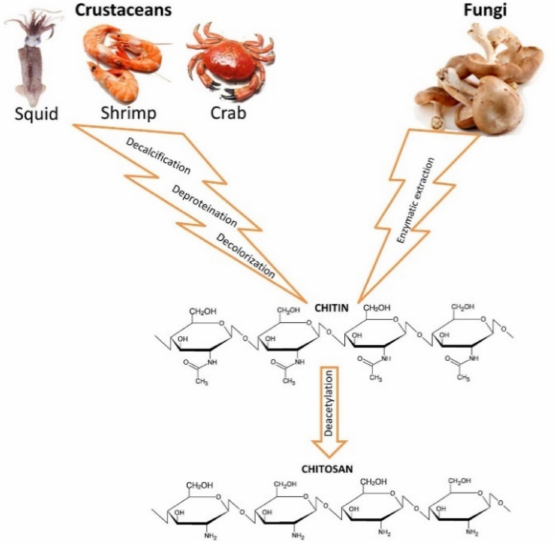
Figure 1. Extraction of chitin and chitosan (CHI) from different sources. Reprinted with the permis- sion from reference [11]. Copyright 2013 American Chemical